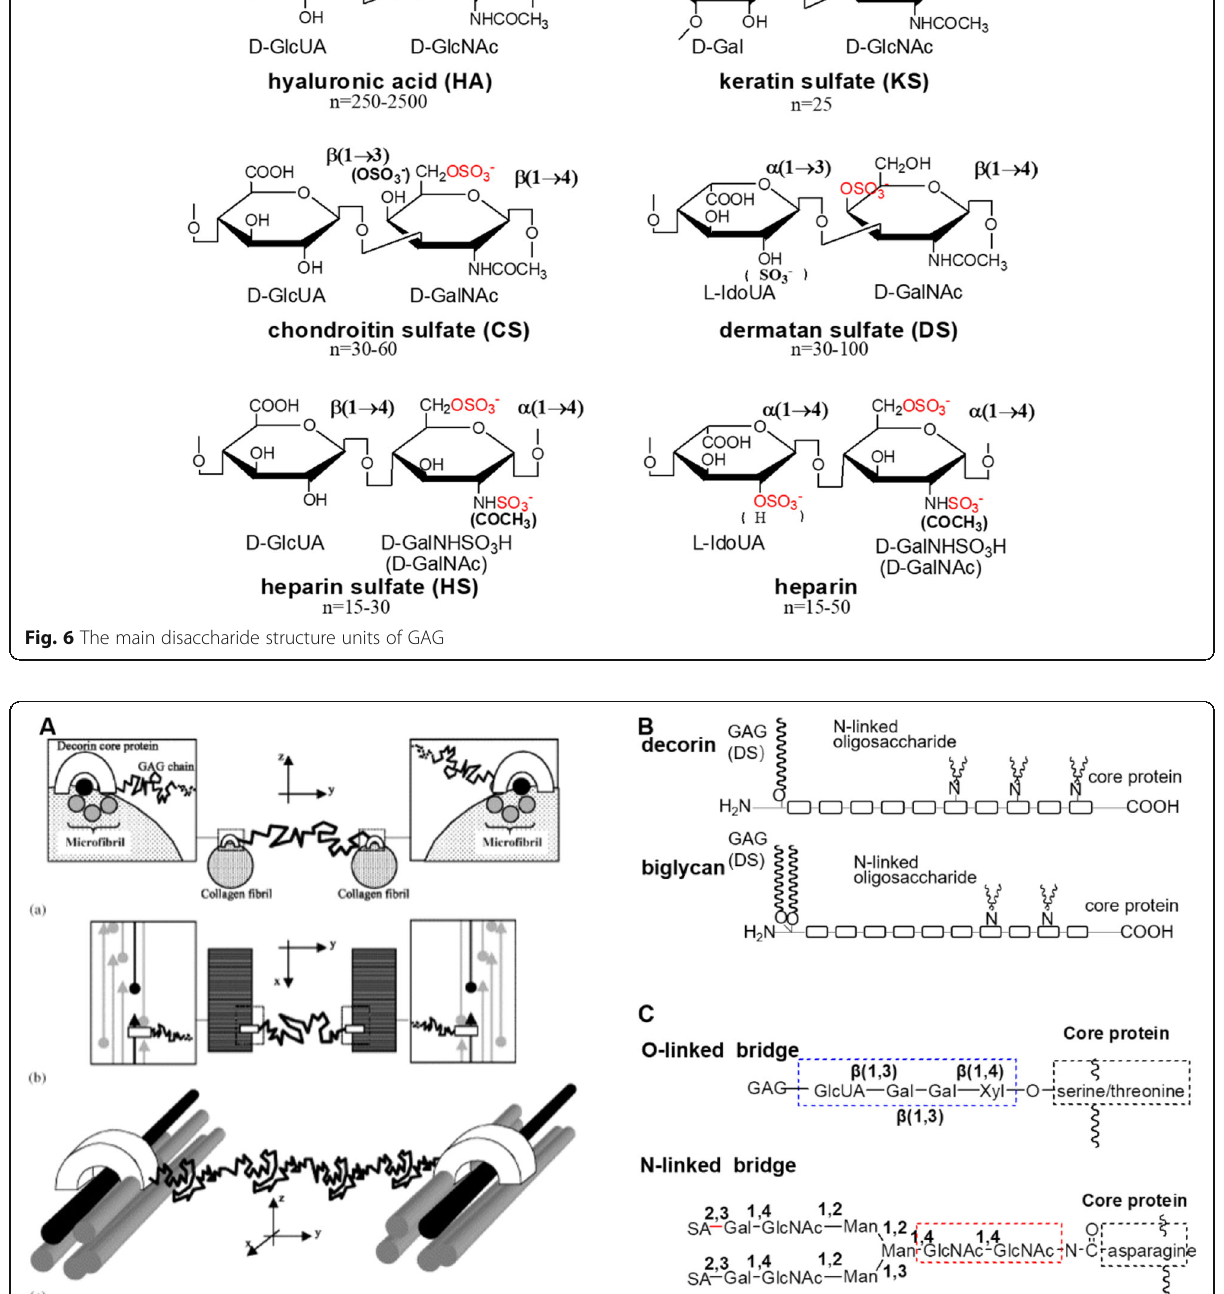
Fig. 7 The schematic of small molecule leucine-rich proteoglycans. a The interaction of two adjacent microfibrils and decorin; it involves two collagen molecules from different microfibrils (shown in black color), two horseshoe-shaped core proteins of decorin (shown in white color) and a GAG chain (shown in jagged black lines). The noncovalent interactions of collagen and decorin are mainly H-bond and electrostatic forces. The color code (Fig. 7a-b) of the collagen molecules shows the quarter stagger model of the collagen molecular assembly. Reprinted from ref. [74] copyright (2004), with permission from Elsevier. b The main small molecule leucine-rich PGs: decorin and biglycan. c Linking ways of saccharide units with core protein in PGs: O-linked bridge and N-linked bridge; Gal: galactose; Xyl: xylose; GlcUA: glucuronic acid; GlcNAc: N- acetylglucosamine; SA: sialic acid; Man: